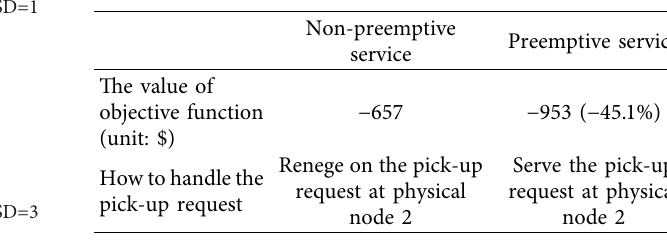
Table 10: Comparison of the solution results under two service